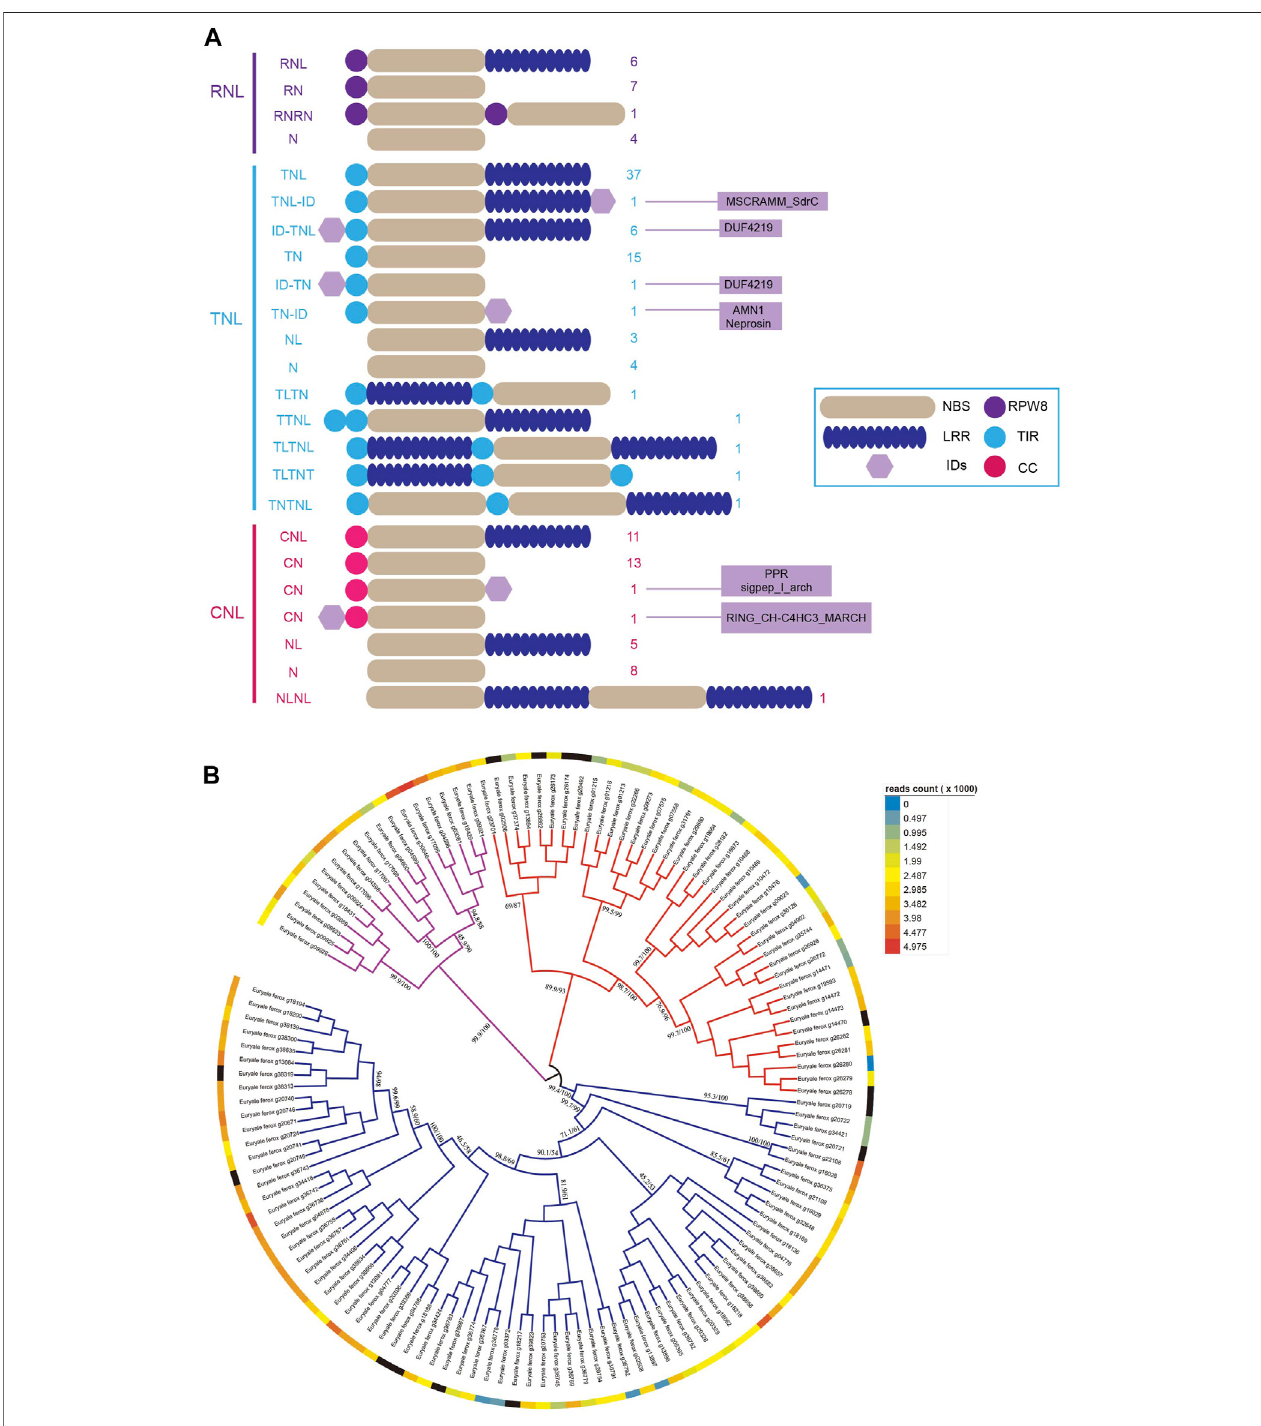
FIGURE 1 | NBS-LRR genes in E. ferox and their domain combinations. (A) Twenty-four domain combinations of NBS-LRR genes in E. ferox . The numbers of NBS-LRR genes of each domain combination are listed and the IDs are also listed as a hexagon. (B) The expression pro fi le of 131 NBS-LRR genes in E. ferox .